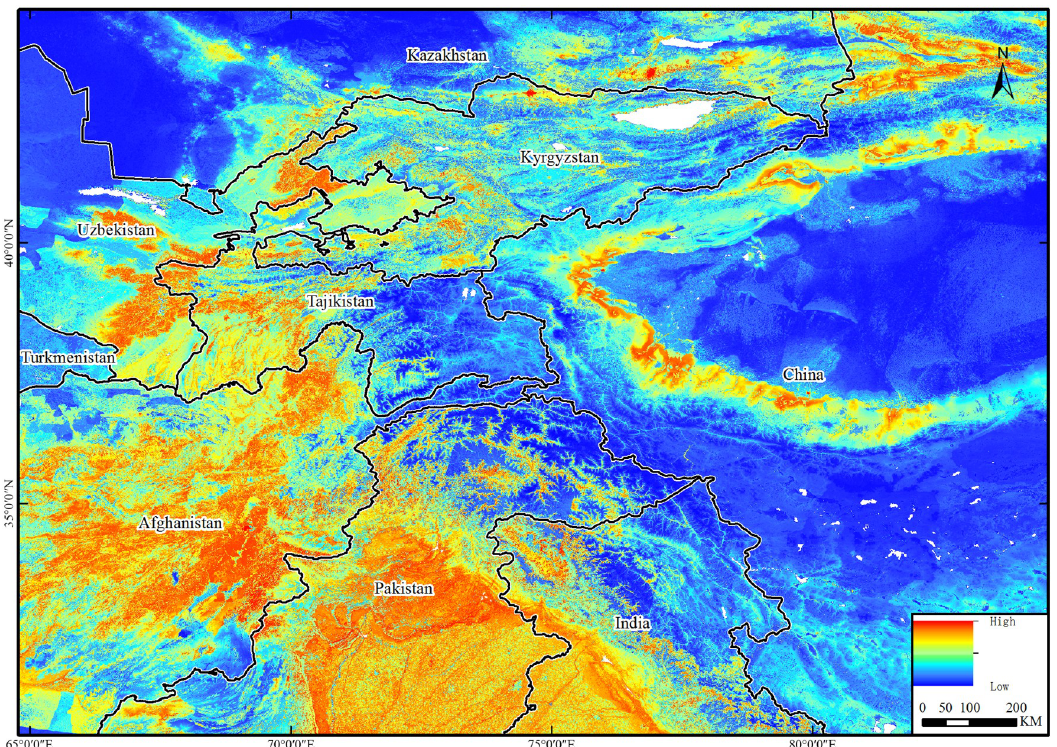
Fig 4. PPR high-risk areas were predicted by the MaxEnt model. This map was made in ArcGIS 10.6 using the resulting rasters produced by MaxEnt. The boundary was obtained from Natural Earth (http://www.naturalearthdata.com/), which is a schematic line illustrating the relative position of each country and should not be re-used or misinterpreted for any political reason.